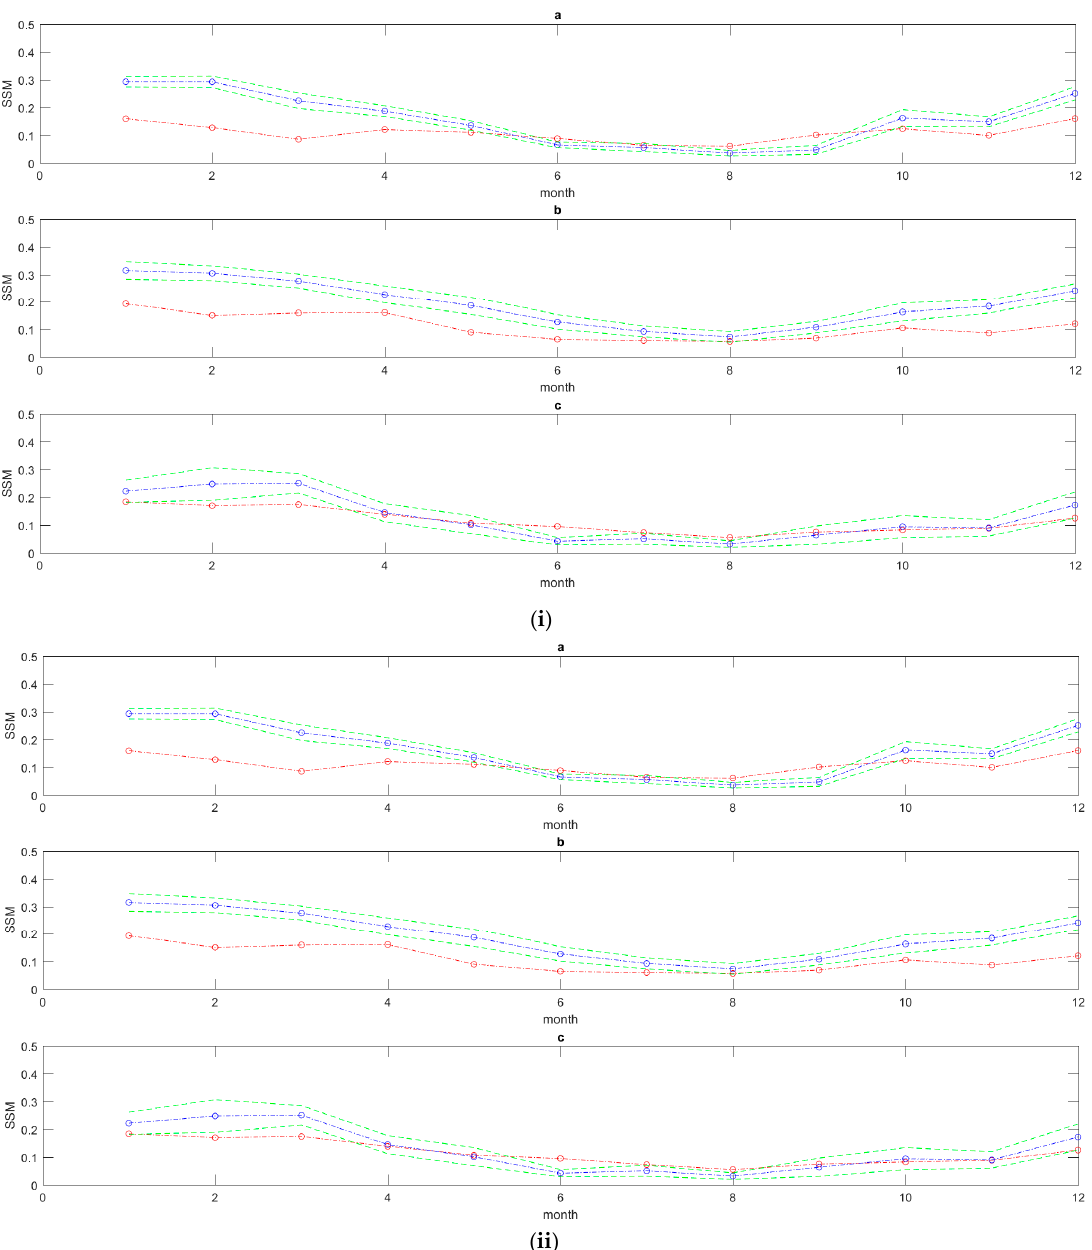
Figure 12. Temporal dependence of monthly averages of in situ and predicted SSM from ASCAT 25Km for the different land cover types in AUSTRALIA. Results are shown for: ( a ) AU_DPA, ( b ) AU_HS, and ( c ) AU_STP. Blue is the ASCAT SSM and red is the in situ SSM ( i ) 2010 and ( ii ) 2011. The green dashed lines represent the 95% confidence level.